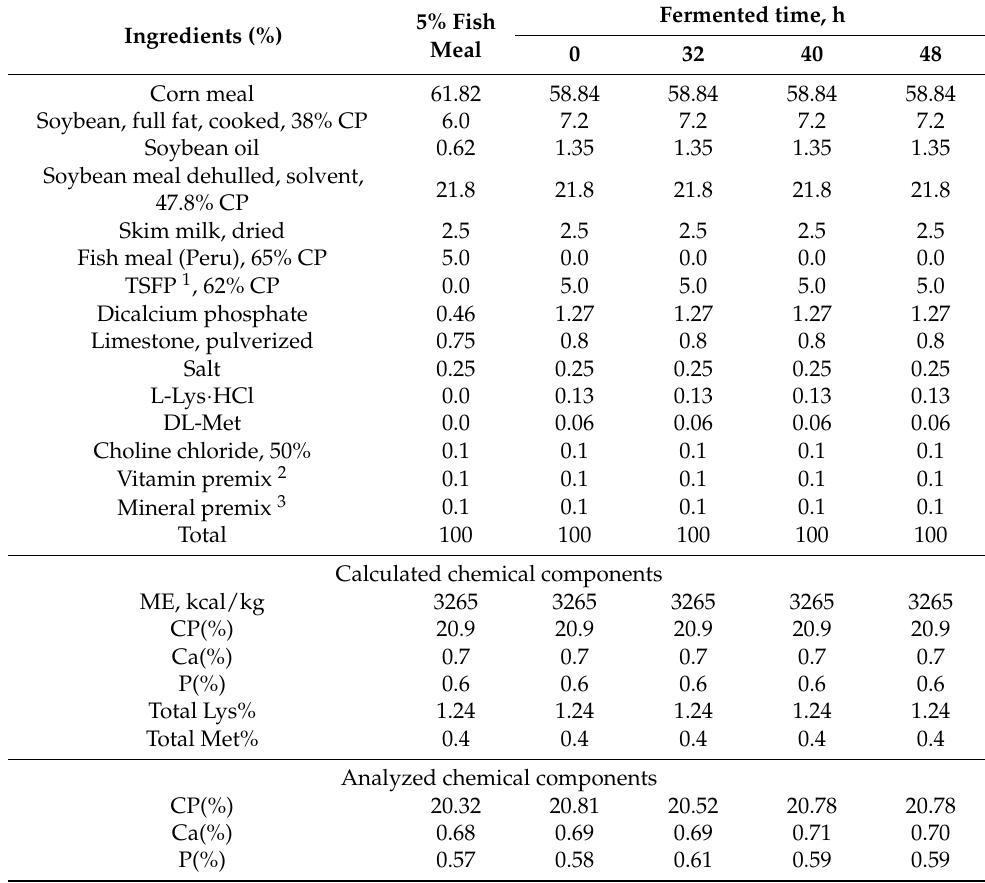
Table 1. Composition of experiment diets (as-fed basis) (trial